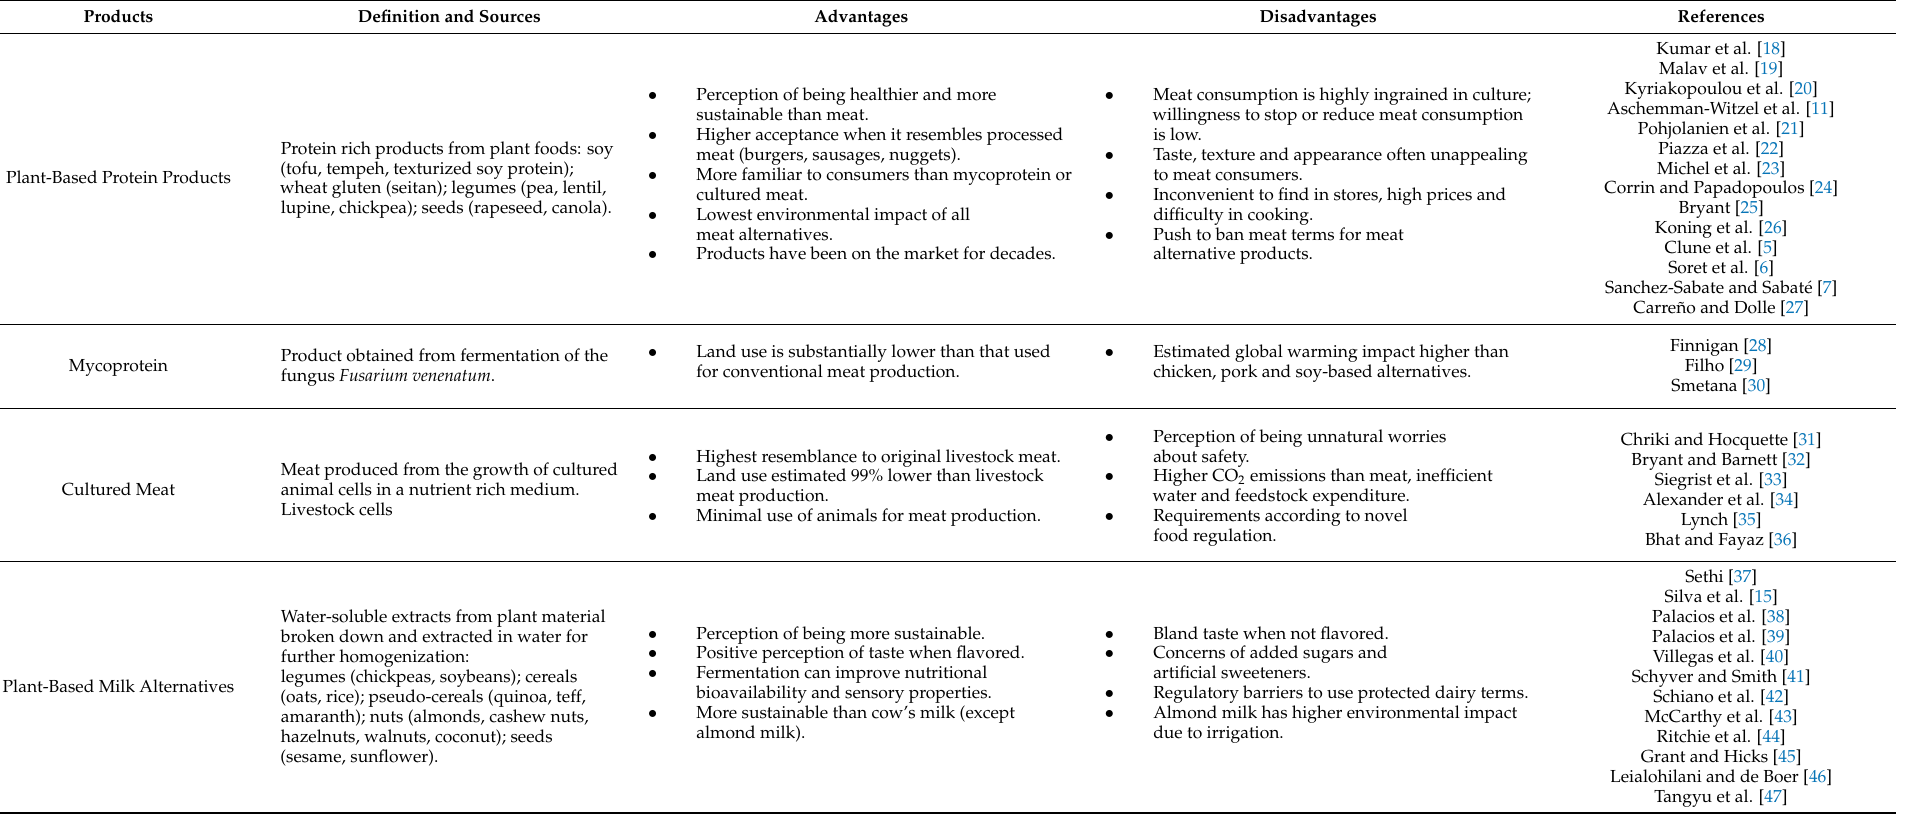
Table 1. Food products for vegetarian and vegan